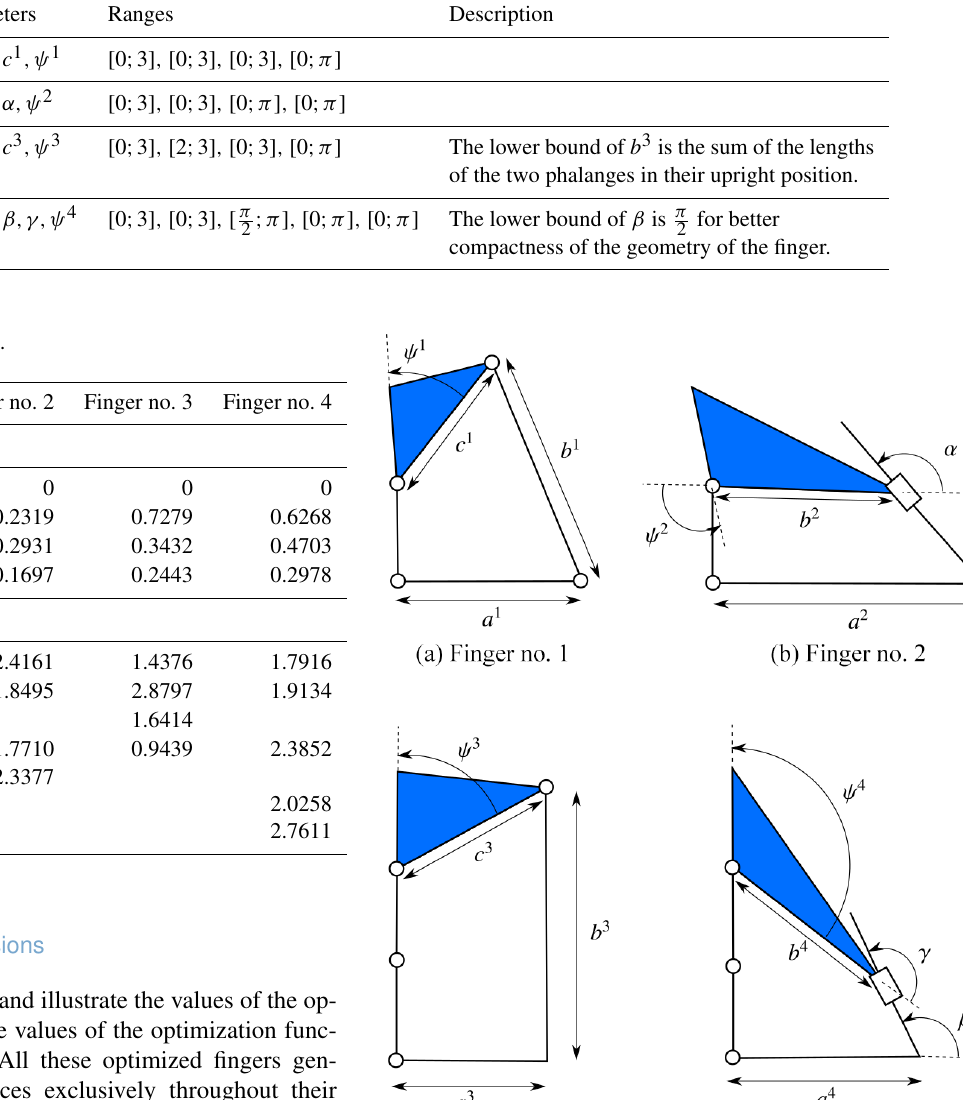
Figure 5. Geometry of the optimized